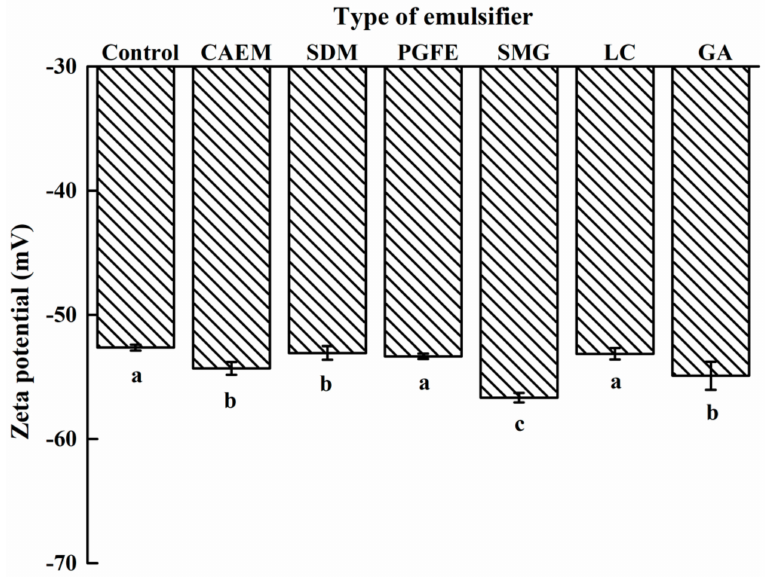
Figure 5. E ff ects of di ff erent emulsifiers on the zeta potential of